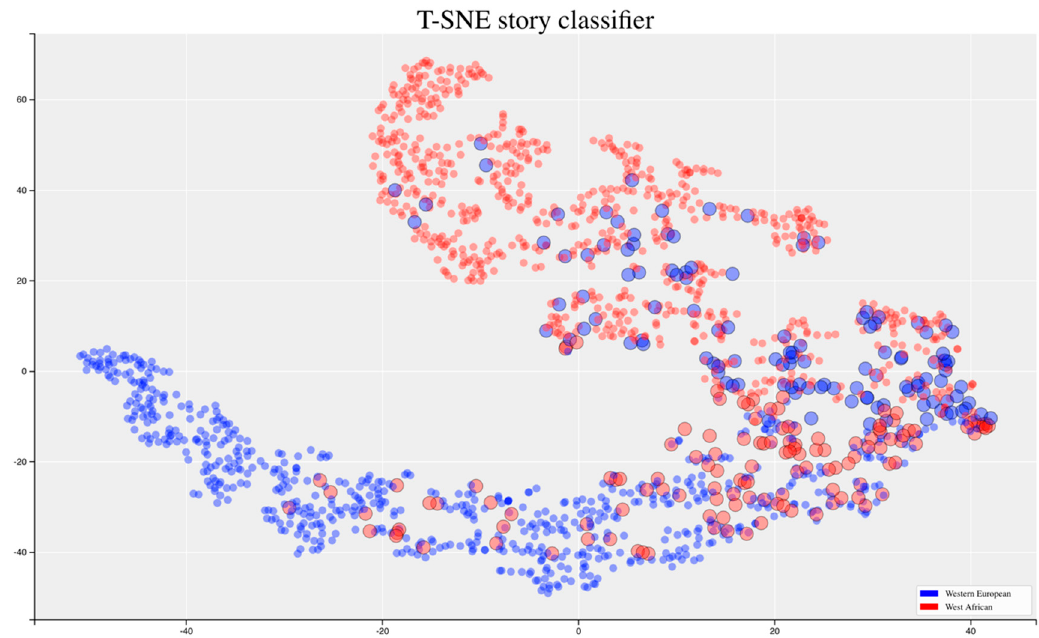
Figure 4. t-SNE visualization with each datapoint symbolizing a sequence of words classified by the hybrid classifier according to geographical background (i.e., West European = blue, West African = red).